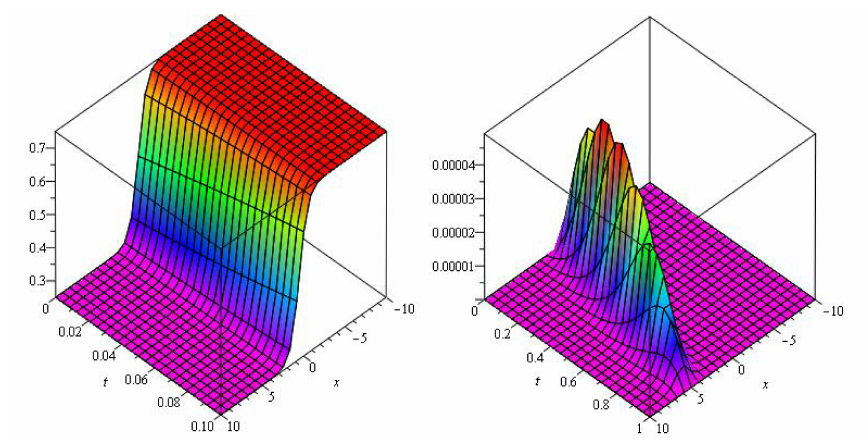
Figure 6. Graphs of ν ( ζ , τ ) and error plot at ρ = 1 of example